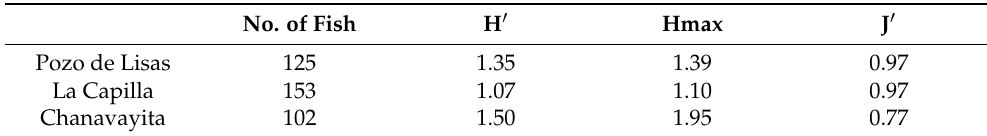
Table 5. Shannon’s dietary diversity values (H (cid:48) ), Shannon ´ s maximum diversity (Hmax), and diet homogeneity (J (cid:48)